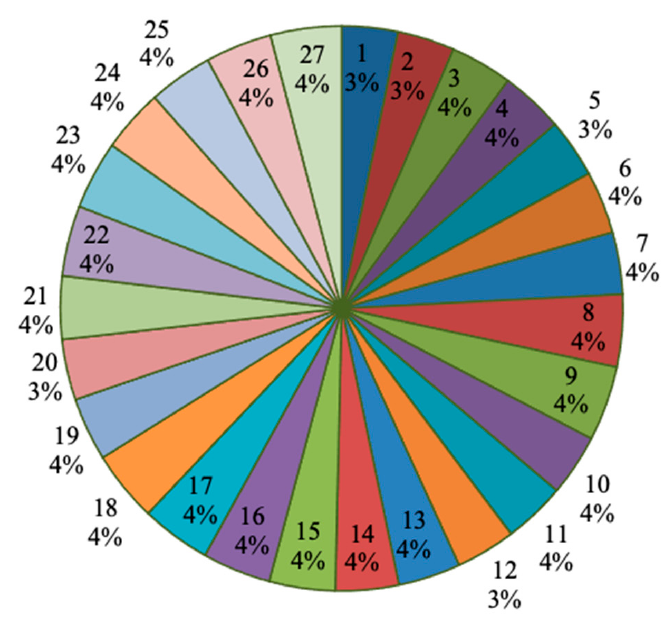
Figure 27. Process parameters influence on the cutting force (N) for each specimen. The experimental results of each specimen’s MRR values were plotted as a radar diagram with the color of light green, as shown in Figure 28. It contains the radius lines as the representation of the individual specimens, and the different concentric circles represent the values of the material removal rate. Similarly, Figure 29 clearly demonstrates the experimental outcomes of the response such as surface roughness as a radar diagram. In this radar diagram, the specimen’s numbers and the corresponding surface roughness values were represented by the radial lines and the concentric circles, respectively. From this aspect, the shape of the surface roughness values relation came out to be like a star shape without uniform intervals, as shown in the color yellow.